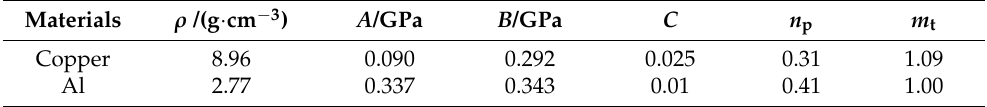
Table 2. Parameters of Cu and Al.